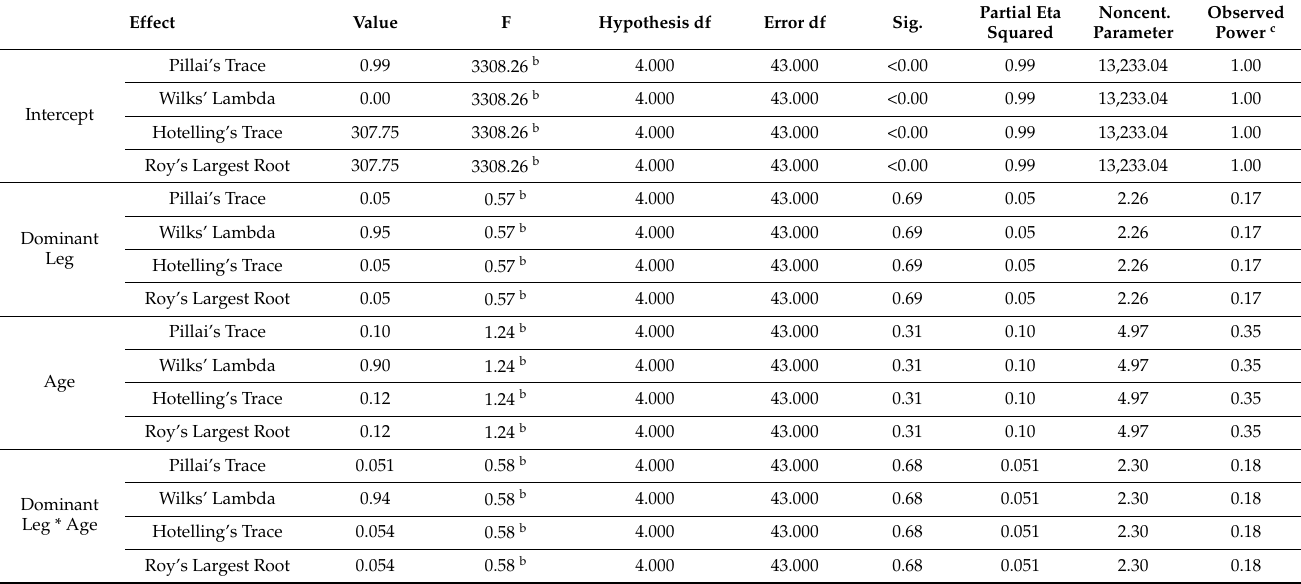
Table 6. Multivariate